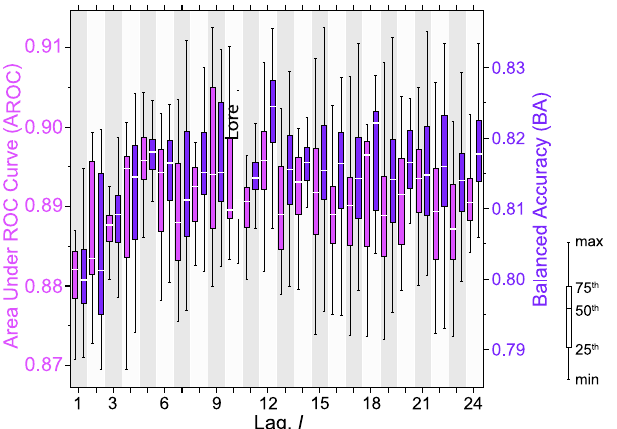
Fig.4|Box-and-whiskerplotsshowingperformanceofthe2400 M ‘ i modelsof set O , in the model testing phase. For each lag, ℓ (x-axis), purple boxplots show variability ofthe A ROC ofthe 100 M ‘ models (lefty-axis),and violet boxplots show